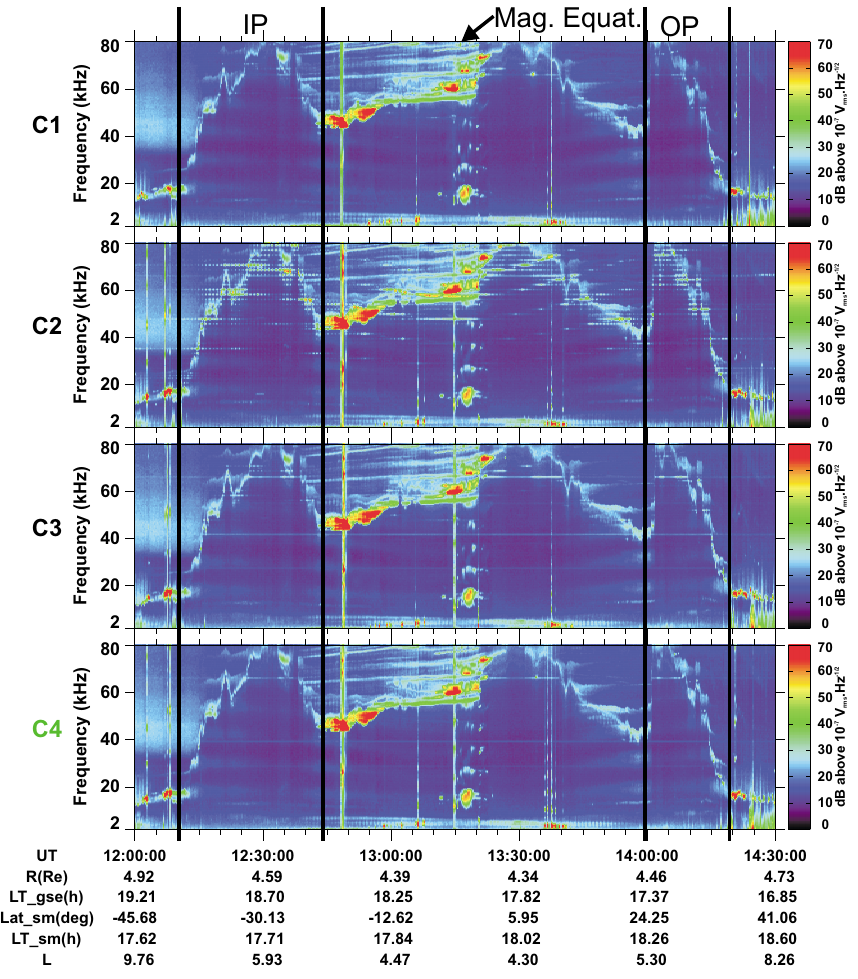
Fig. 8. Frequency-time spectrograms measured by the four CLUSTER/WHISPER instruments on 2 June 2002, showing the entire plasma- sphere crossing, including plume traversals in the inbound (IP) and outbound passes (OP) and the magnetic equator (Mag. Equat.) crossed around 13:20 UT. The orbital parameters correspond to